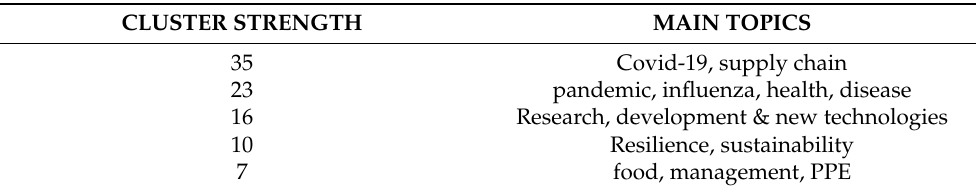
Table 12. Main Topics with Major Link Strength and with ≥ 4 Occurrences.